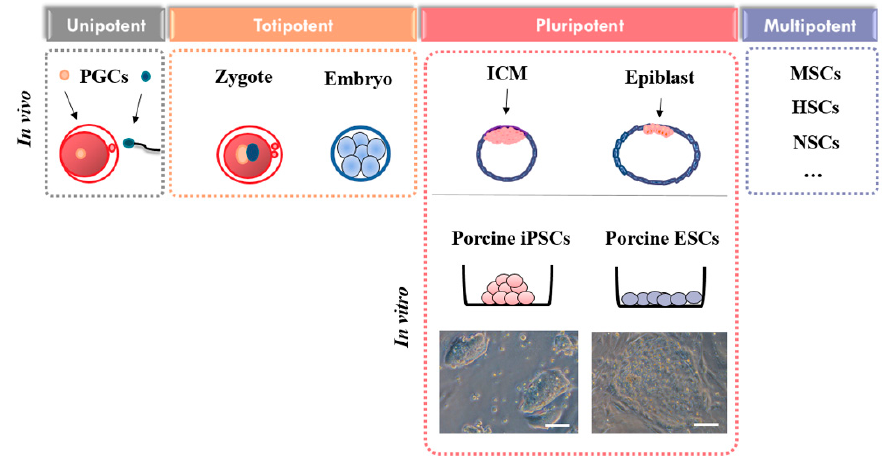
Figure 1. Stem cell state in vivo and in vitro. PGCs: Primordial germ cells, ICM: inner cell mass, iPSCs: induced pluripotent stem cells, ESCs: embryonic stem cells, MSCs: Mesenchymal stem cells, HSCs: Hematopoietic stem cells, NSCs: Neural stem cells. Scale bars = 50 µm.